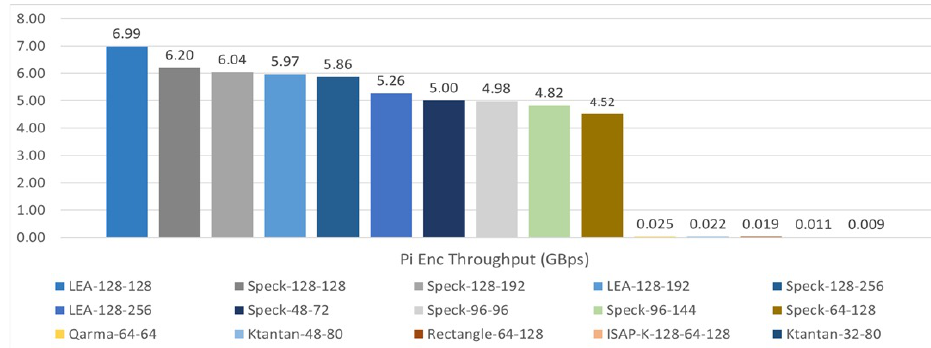
Figure 14. The 10 largest speed throughput in ENC and 5 least in Pi.